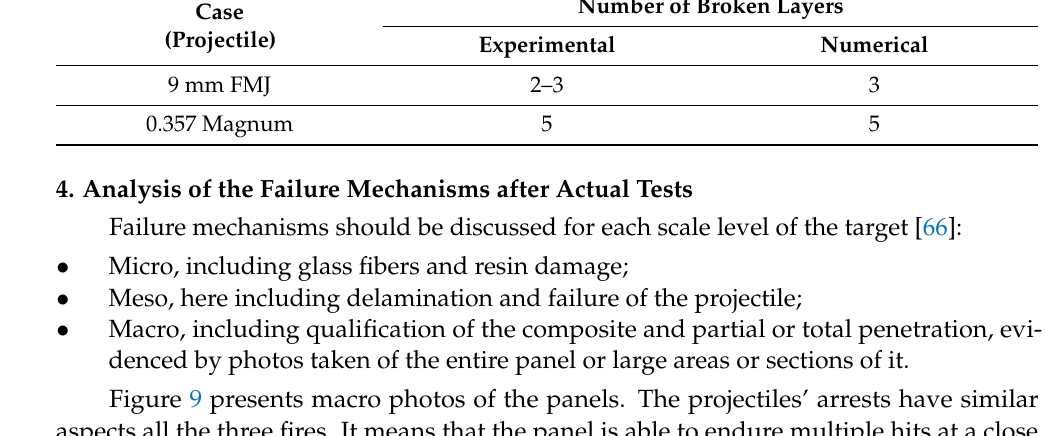
15 of 21 Figure 8. Cross section of the panel, at different time moments, for each modeled case (projectile is transparent) (color scale is given for each image, in MPa). ( a ) 9 mm FMJ. ( b ) .357 Magnum. Comparing the images of t he panels at t = 4.5 × 10 − 5 s to those at t = 1.5 × 10 − 4 s (the simulation’s end), one may notice that even if there were no more breaks in the layers